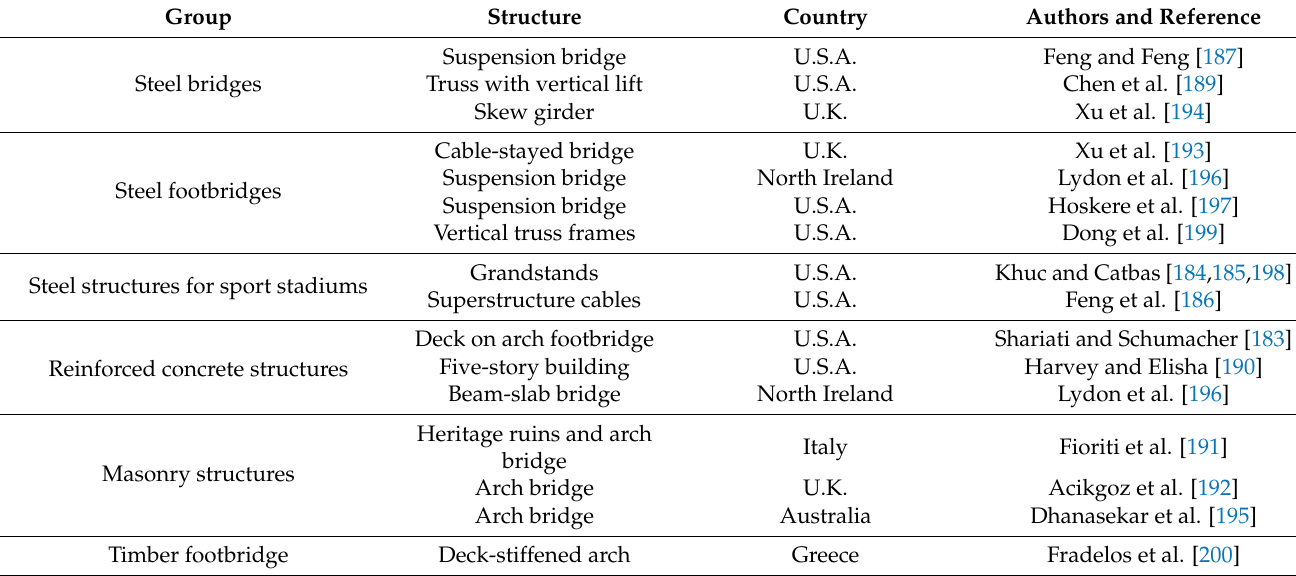
Table 1. Recent field applications of vision-based vibration monitoring in civil engineering.